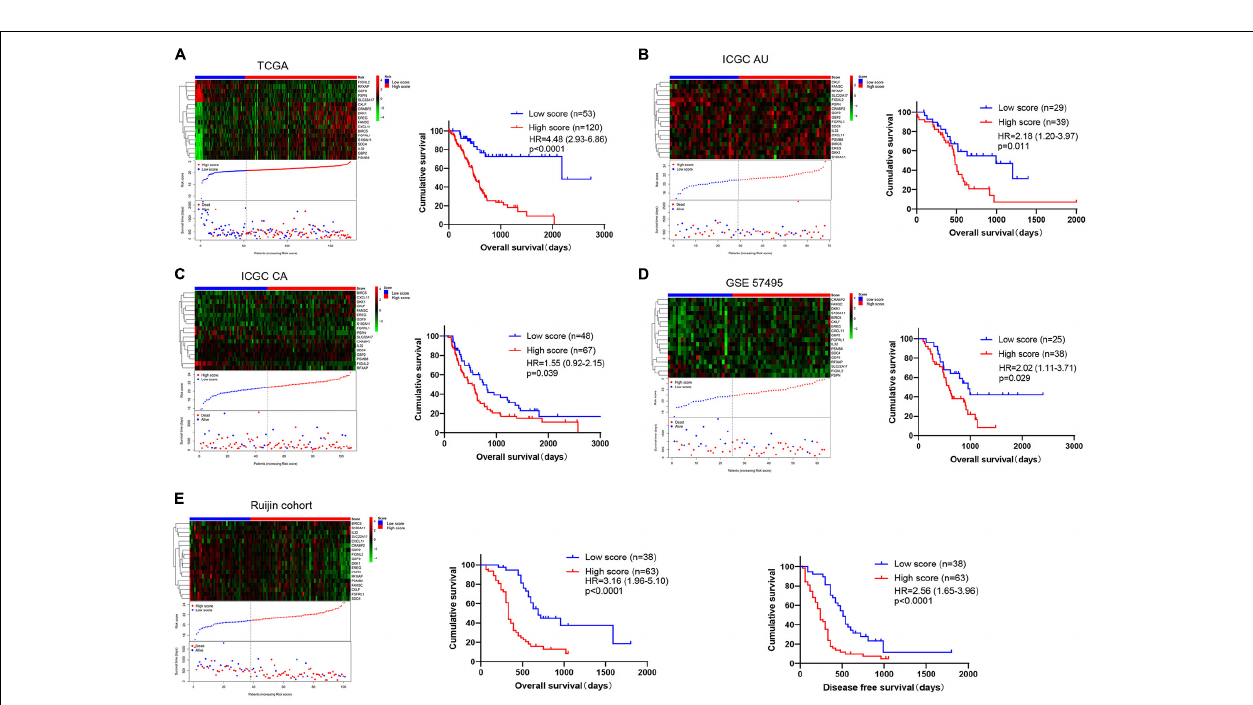
FIGURE 3 | The distribution and Kaplan-Meier survival curves of the immunity-related 18-gene signature depends on the patients’ risk score. The risk score for all patients with PDAC were plotted in ascending order and marked as low score (blue) or high score (red). The survival status of the patients is marked as dead (red) and alive (blue). The proportion of patients who died in the high score group is obviously higher compared with that in the low score group. (A) TCGA ( n = 173), (B) ICGC AU ( n = 68), (C) ICGC CA ( n = 115), (D) GSE57495 ( n = 63), and (E) Ruijin cohort ( n = 101) are shown, respectively, and the Ruijin cohort also exhibited the